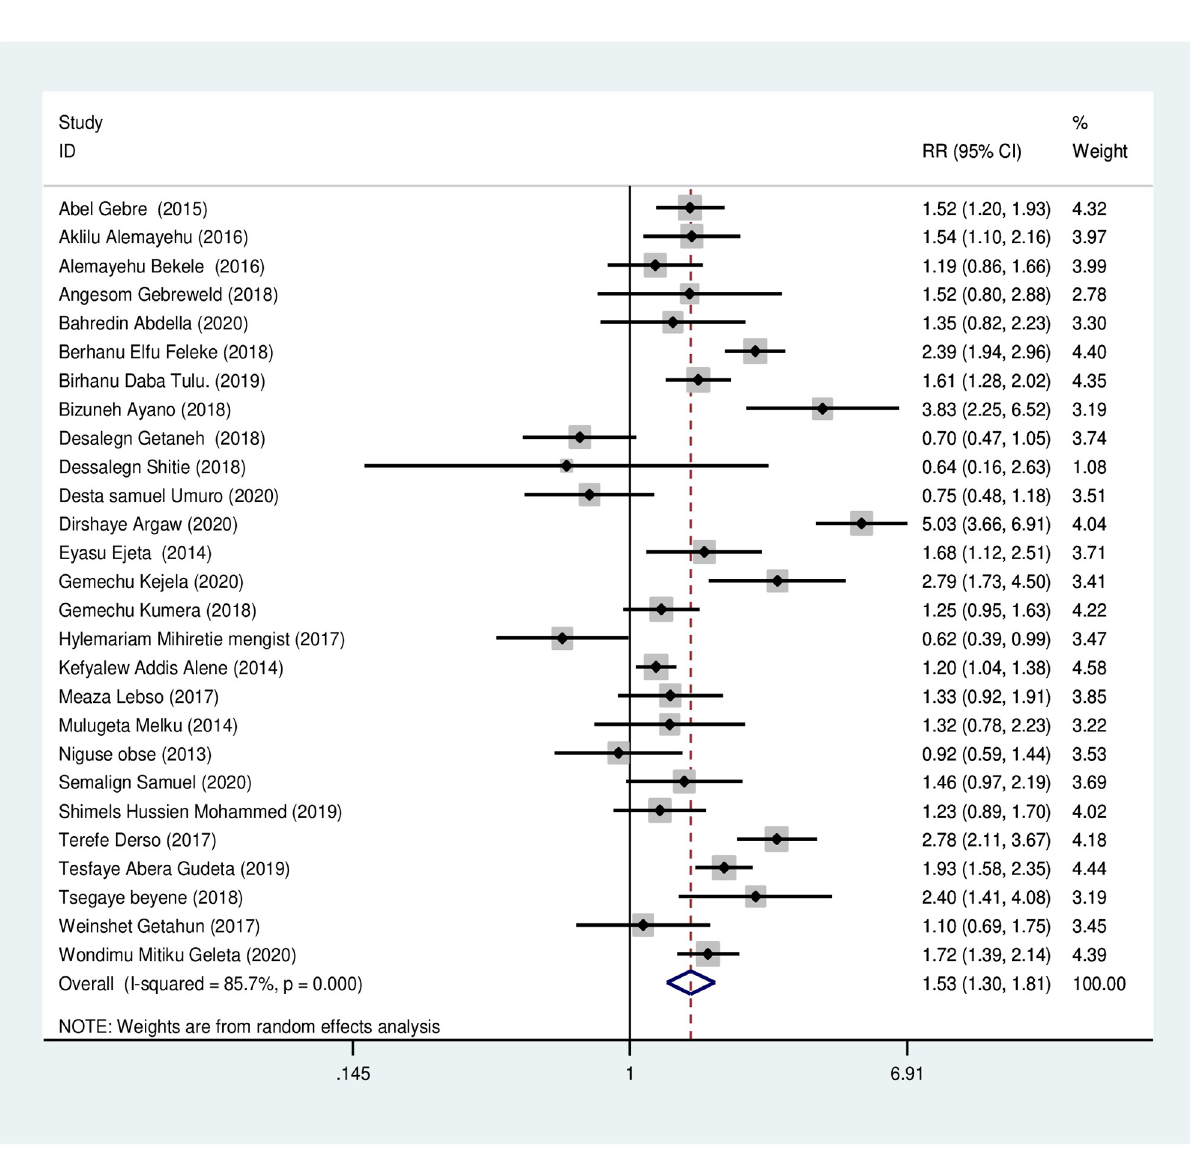
Fig 3. Association of iron-folic acid supplementation with anemia during